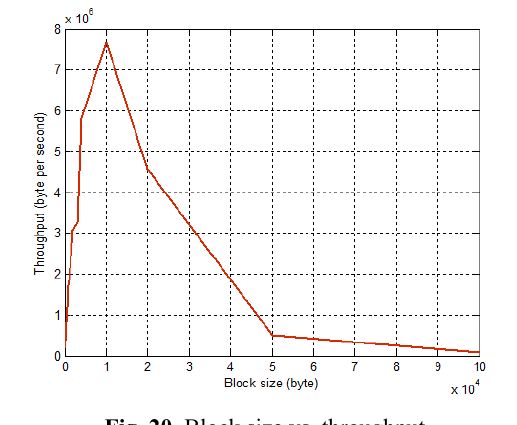
Fig. 18. Encryption time vs. block size Fig. 19. Total encryption time vs. block size